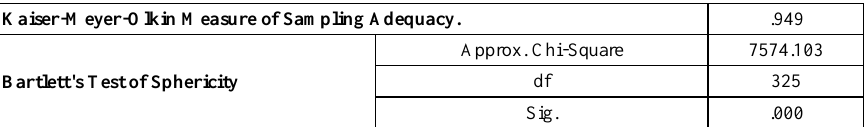
Table 6. KMO and Bartlett's Test Kaiser-Meyer-Olkin Measure of Sampling